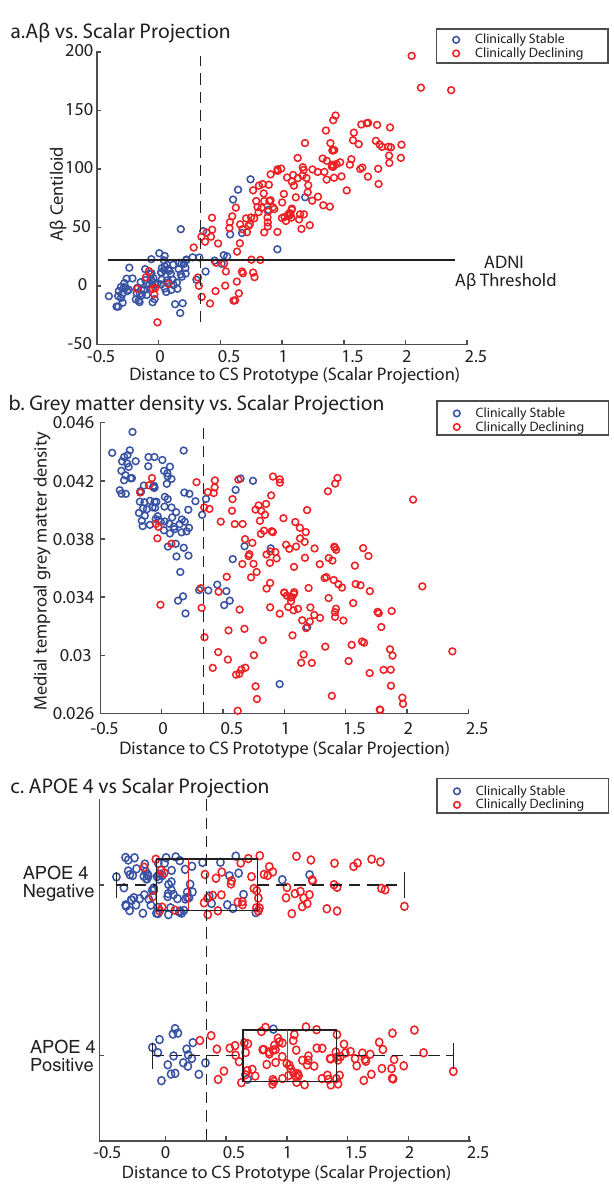
Fig. 2 Relationship of scalar projection with biological predictors. ADNI2/ GO sample: blue dots indicate individuals in the Clinically Stable group, red dots indicate individuals in the Clinically Declining group. Dashed lines indicate the learnt probabilistic boundary that separates Clinically Stable from Clinically Declining. The scalar projection represents a scalar value from the projection of any sample point along the model-derived prognostic axis, where a scalar projection of 0 represents the median Clinically Stable individual and a value of 1 represents the median Clinically Declining individual. a Relationship of scalar projection with FBP centiloids (A β ), the solid horizontal line indicates the ADNI threshold for A β positivity (SUVR = 1.11). b Relationship of scalar projection with medial temporal grey matter density. c Relationship of scalar projection with APOE 4 status ( n APOE 4 positive = 116, n APOE 4 negative = 140), the red line is the median of the group, the solid black box represents the 25th to 75th percentile and the dashed black lines represent the range of the data. Source data are provided as a Source Data fi